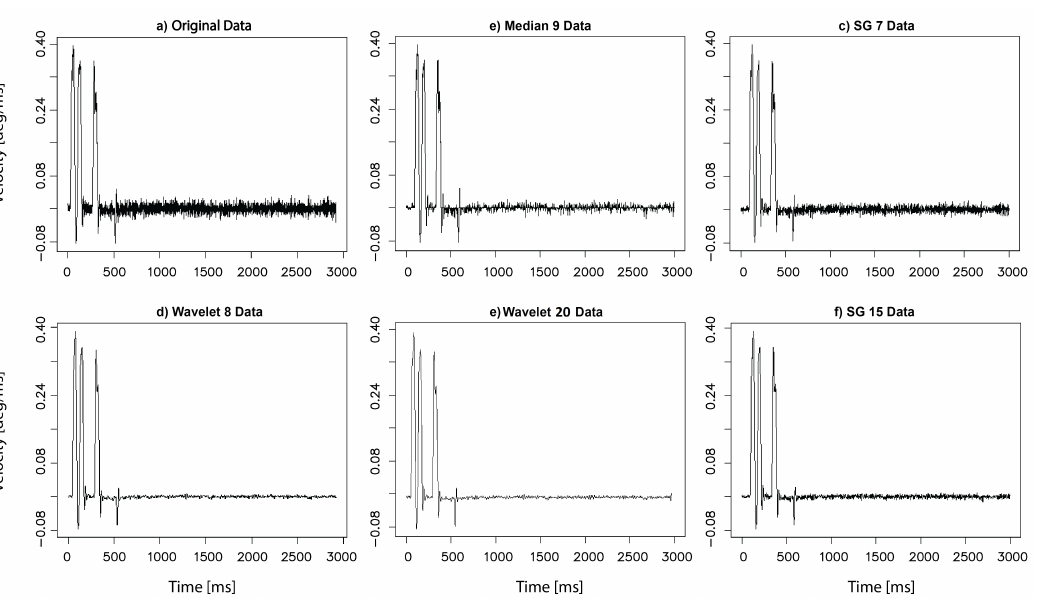
Figure 4. An example time series in the original form ( a ) denoted in text by N and after various filter application: ( b ) M9, ( c ) SG7, ( d ) W8, ( e ) W20 and ( f ) SG15.